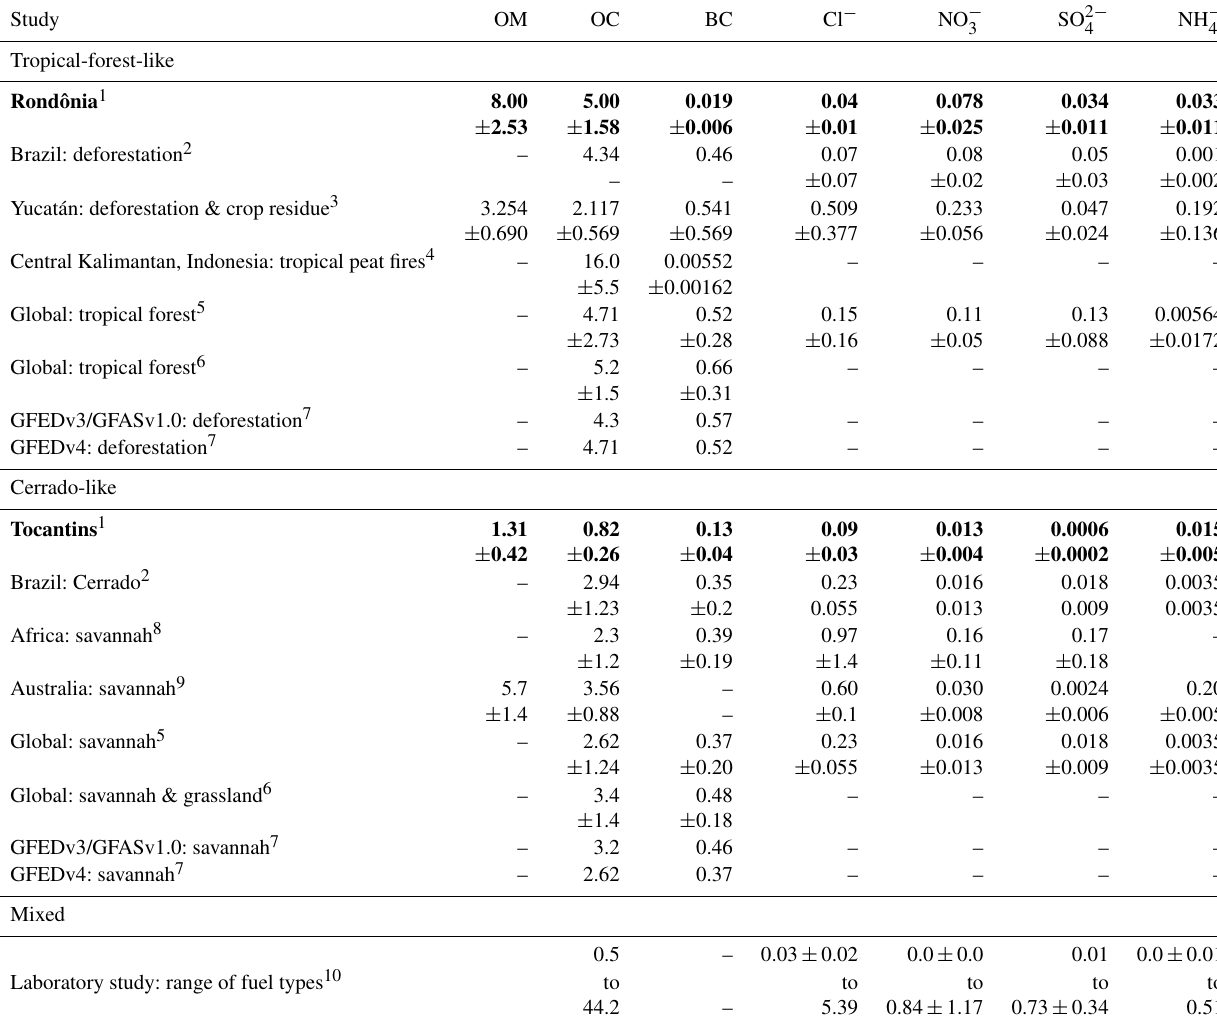
Table 6. Particulate species emission factors (gkg − 1 of dry fuel burnt) for Rondônia and Tocantins fires determined using the calculations as shown in Sect. 2.2.4. EF values from previous studies in Brazil are included for comparison with the specific fuel type stated. Also included are EFs from different geographical locations around the world and values used in GFEDv3/GFASv1.0 and GFEDv4 emission inventories (van der Werf et al., 2010; Kaiser et al., 2012). Values in bold are from this